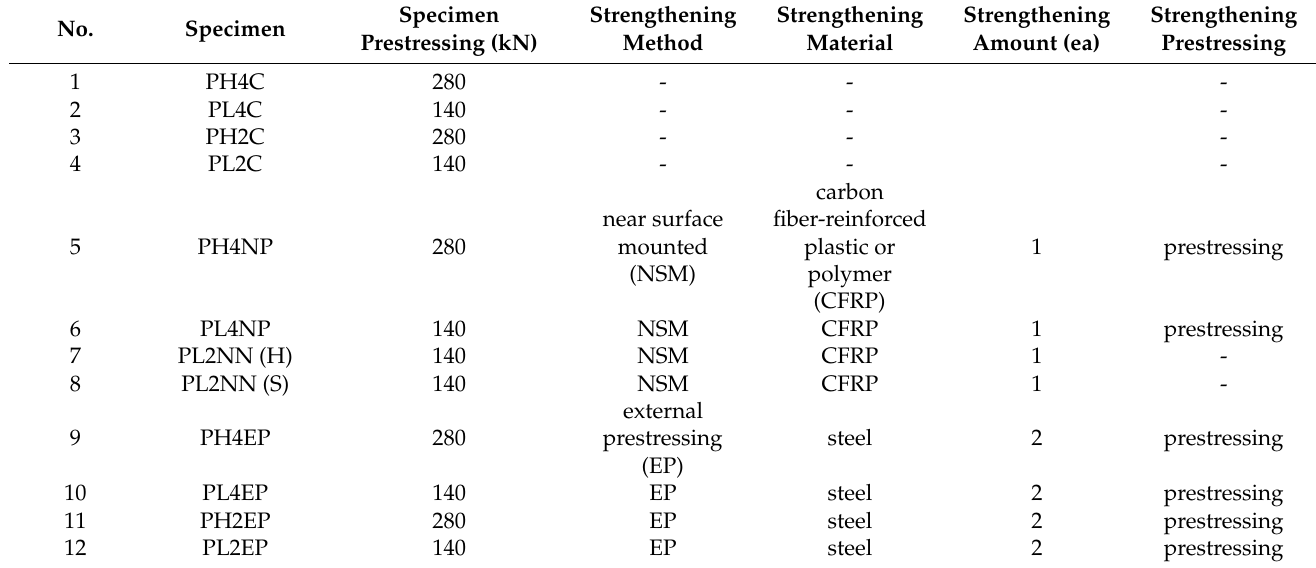
Table 2. Description of test specimens (the codification of specimens is explained in Figure 2).